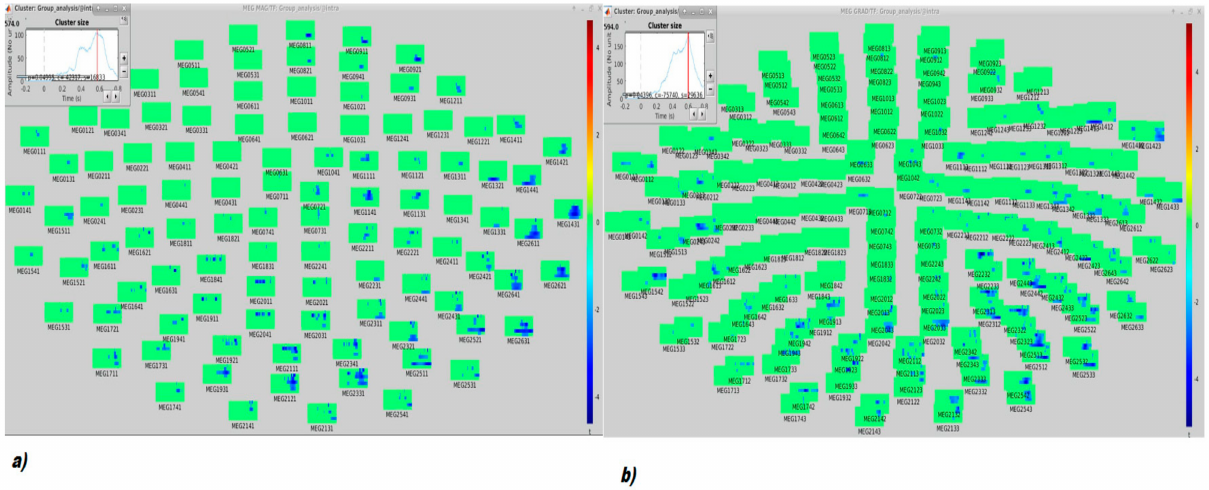
Figure 4. Topographical (and temporal, top left inset) distribution of the significant cluster (for ( a ) gradiometer, p = 0.049; ( b ) magnetometer p =